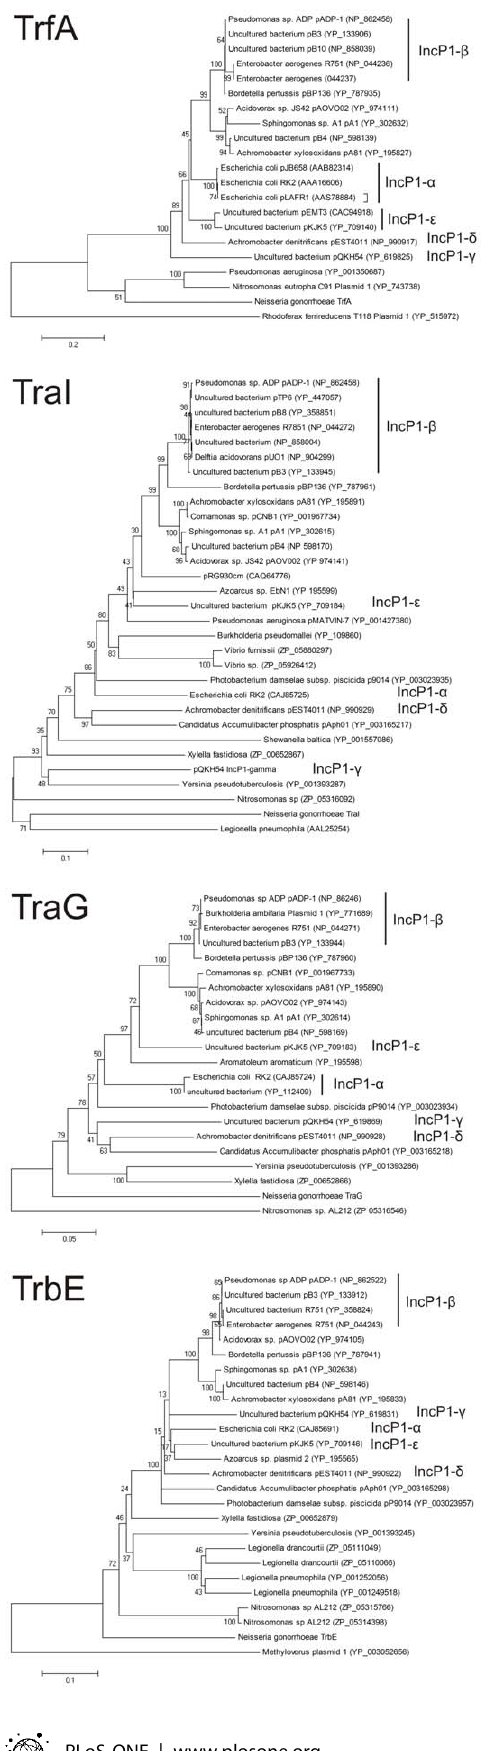
Figure 3. Phylogenetic analysis of genes of different IncP1 plasmids. The TraI (A), TrbE (B), TraG (C) and TrfA (D) proteins of the neisserial conjugative plasmids and of representative members of different IncP1 plasmid subfamilies ( a , RP4; b , pADP-1; c , QKH54; d , pEST4011 and e , pKJK5) representative for different regions of the conjugative plasmids were used to create phylogenetic trees of the IncP1 plasmid family. (For details see materials and methods).